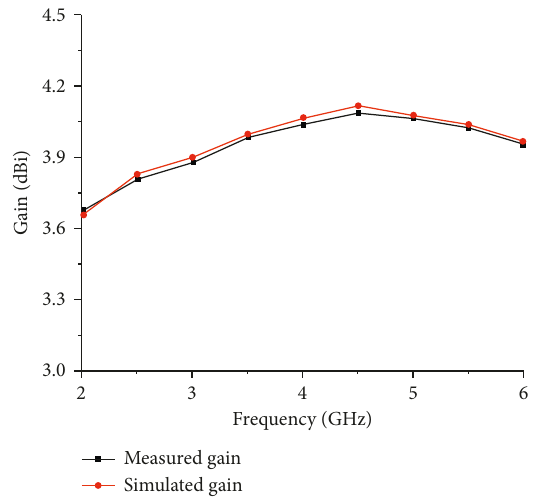
Figure 12: Measured radiation gain of the proposed antenna in the + Z